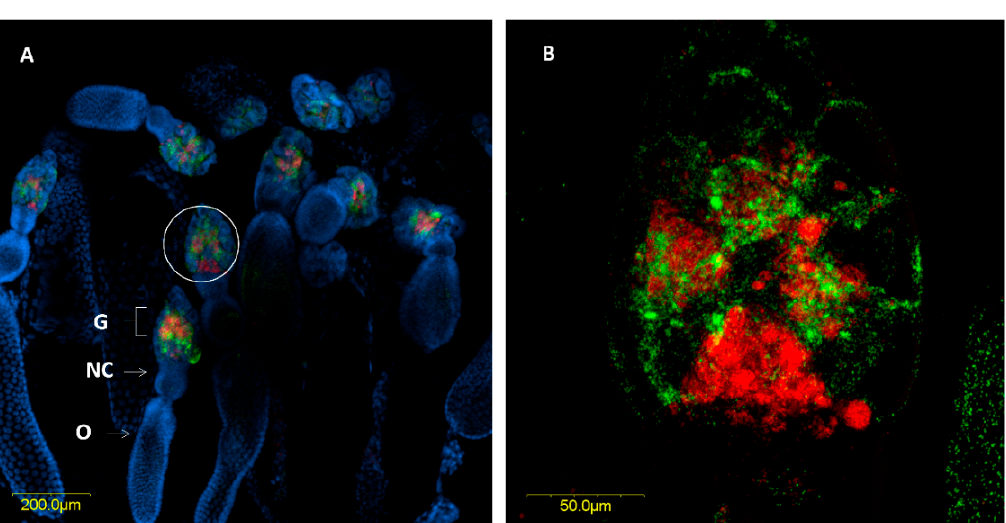
Figure 5. FISH of a female M. pygmaeus digestive system (DNA in blue). ( A ) The whole digestive system, R. bellii (red), R. limoniae (green). Reconstruction: three frames of the same gut; from F to M2 picture number 1, M3 picture number 2, M4 to OV picture number 3. ( B ) Enlarged section of the outgrowth caeca region, in the gut tissue of the third midgut section (white circle 1 in A). ( C ) Enlarged section of Malpighian tubules (white circle 2 in A). Images A number 1, A number 2, A number 3, B and C represent serial Z sections of 20 µm, 55 µm, 50 µm, 12 µm, 17 µm respectively. F, foregut; M1, midgut first section; M2, midgut second section; M3, midgut third section (with outgrowth caeca); M4, midgut fourth section; MT, Malpighian tubules; H, hindgut; OV, ovipositor.